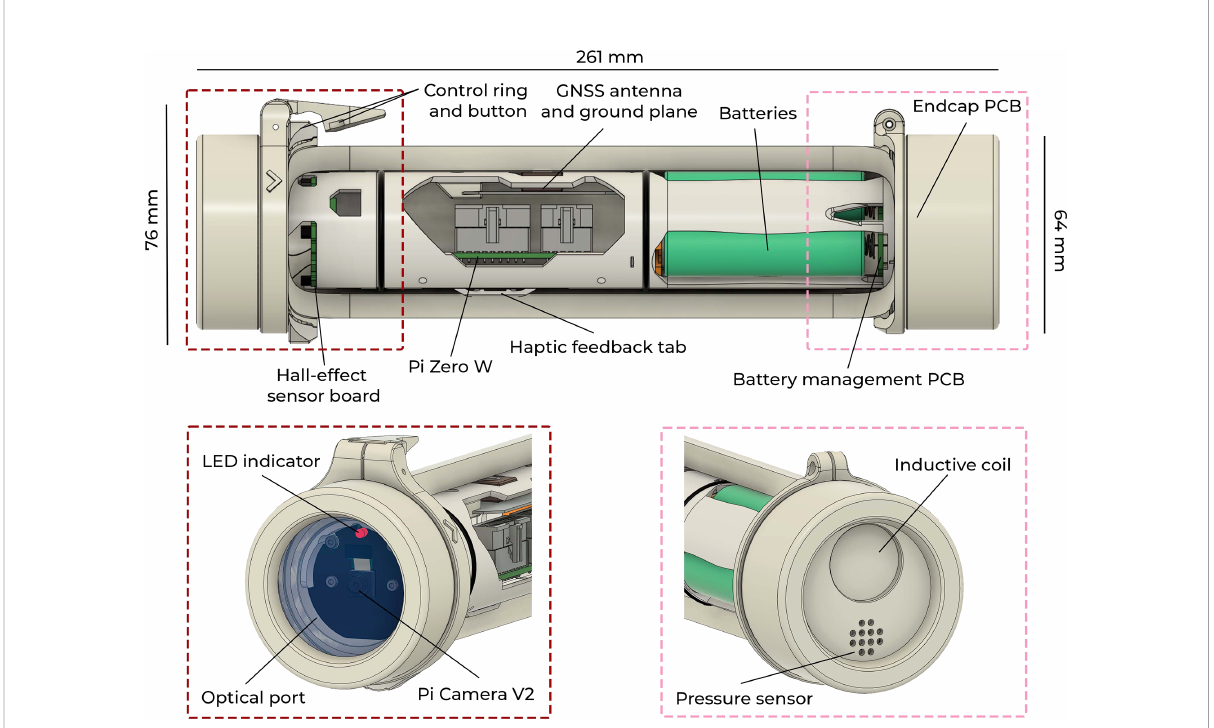
FIGURE 5 A partial cutaway of the housing exposes the dry chassis and the electrical components within. At the front are the optical port, the Raspberry Pi Camera Module and an LED indicator. At the rear are the charging port and the pressure